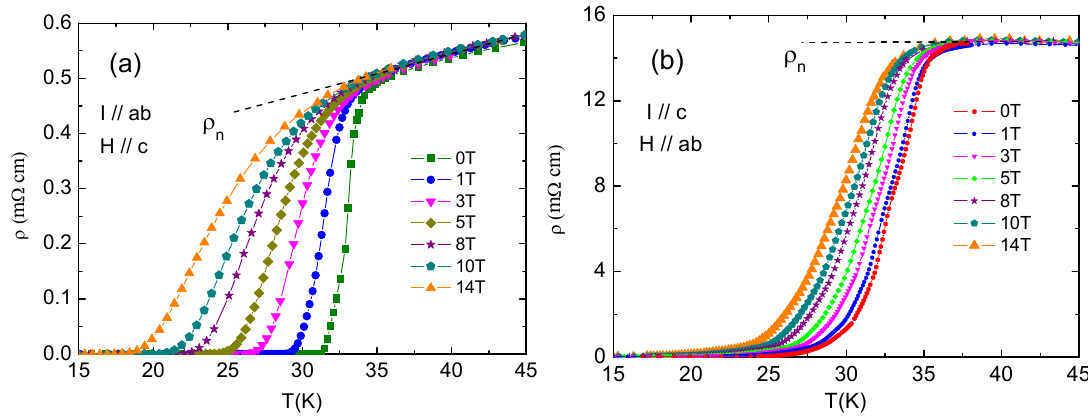
Figure 6. ( a ) The temperature dependence of ρ ab with applied magnetic field H = 0, 1, 3, 5, 8, 10, and 14 T along the c direction in the superconducting state; ( b ) the temperature dependence of ρ c with applied magnetic field H = 0, 1, 3, 5, 8, 10, and 14 T along the ab plane in the superconducting state. As shown in Figure 7, the H c 2 ( T ) of Ca 10 (Pt 4 As 8 )((Fe 0.86 Pt 0.14 ) 2 As 2 ) 5 was extracted by identifying the T c ( H ) at which resistivity drops to 90% ρ n , 50% ρ n , and 10% ρ n . ρ n is the normal resistivity before superconducting transition, as indicated by dashed lines in Figure 6.